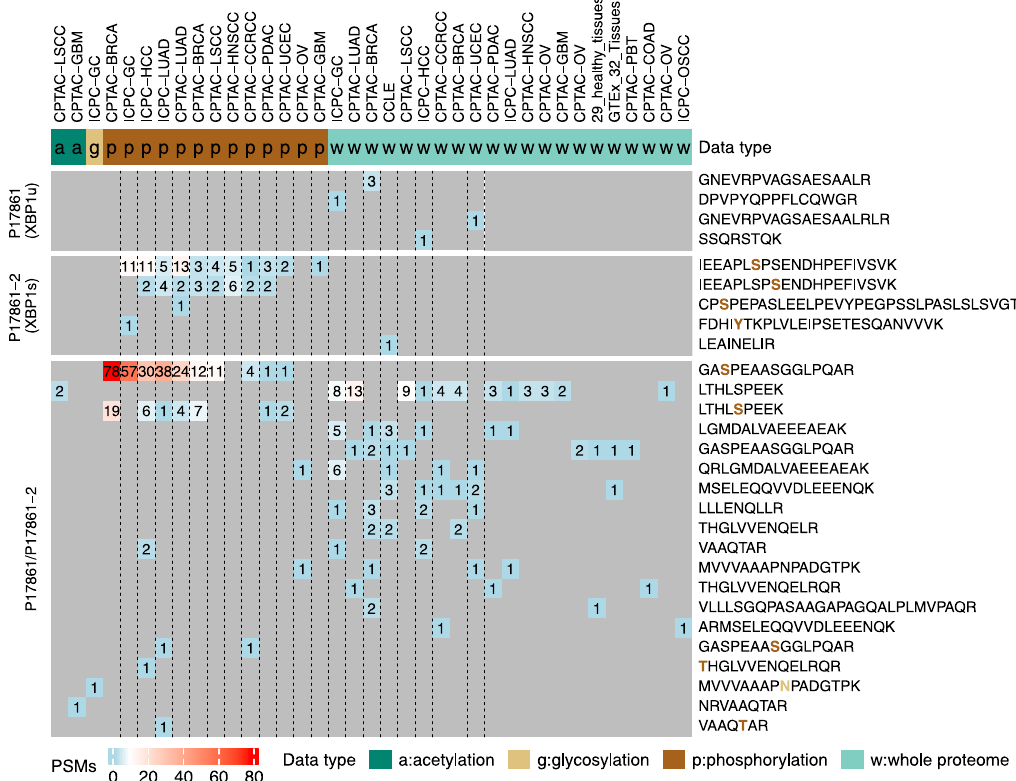
Fig. 7 | Protein isoform identi fi cation. The distribution of XBP1 isoform-speci fi c and shared peptide identi fi cations across different MS/MS datasets in PepQueryDB. Source data are provided as a Source Data fi